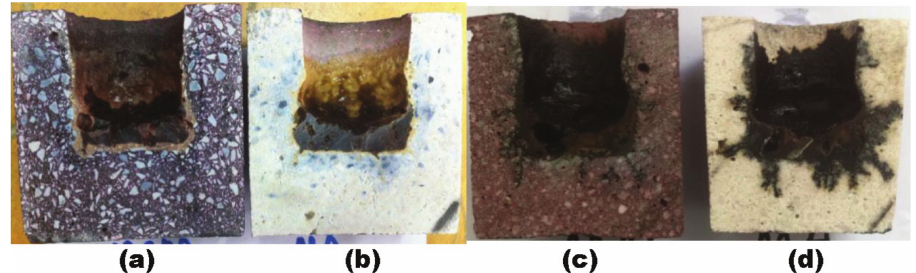
Figure 6: Comparison of slag resistance tests: (a) and (c) are chromium slag and (b) and (d) are traditional MgAl 2 O 4 spinel.